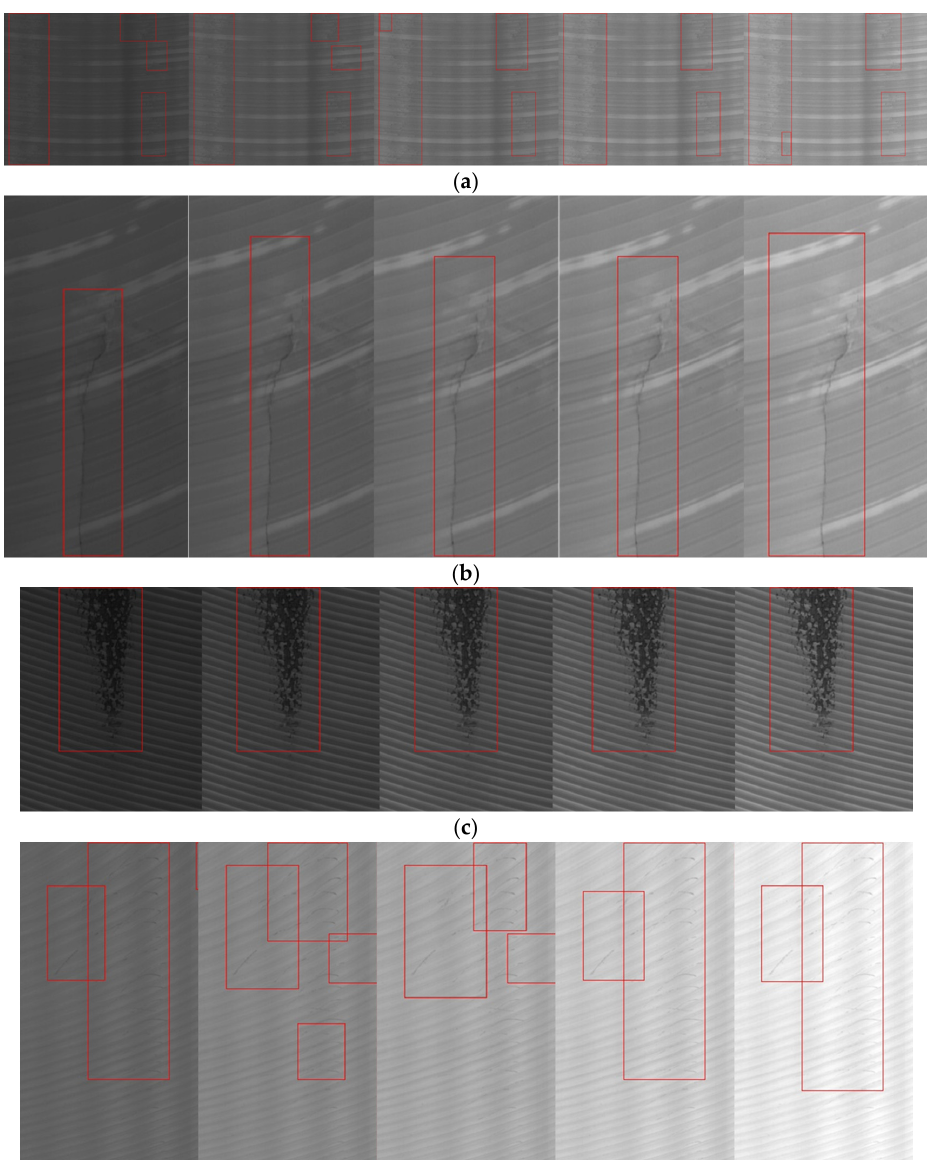
Figure 19. Detection e ff ect of di ff erent brightness: ( a ) PSI; ( b ) OF; ( c ) PSI; ( d ) Sc. From left to right, the brightness of the image is reduced by 40%, reduced by 20%, unchanged, increased by 20%, and increased by